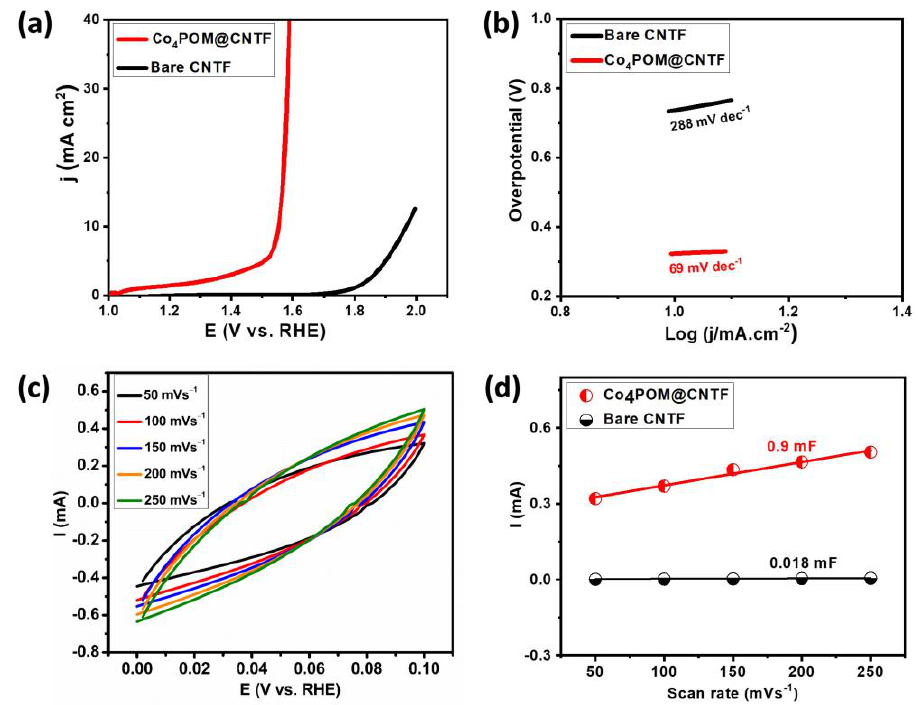
Figure 4. ( a ) LSV curves for CNTF and Co 4 POM@CNTF in 0.1 M KOH at a scan rate of 10 mV s − 1 ; ( b ) Tafel plots for bare CNTF and Co 4 POM@CNTF; ( c ) cyclic voltammograms for Co 4 POM@CNTF at various scan rates from 50–250 mV/s; ( d ) scan rate versus current plots for the bare CNTF and Co 4 POM@CNTF. Table 1. Comparison of electrochemical parameters calculated for the bare CNTF and Co 4 POM@CNTF in alkaline media.